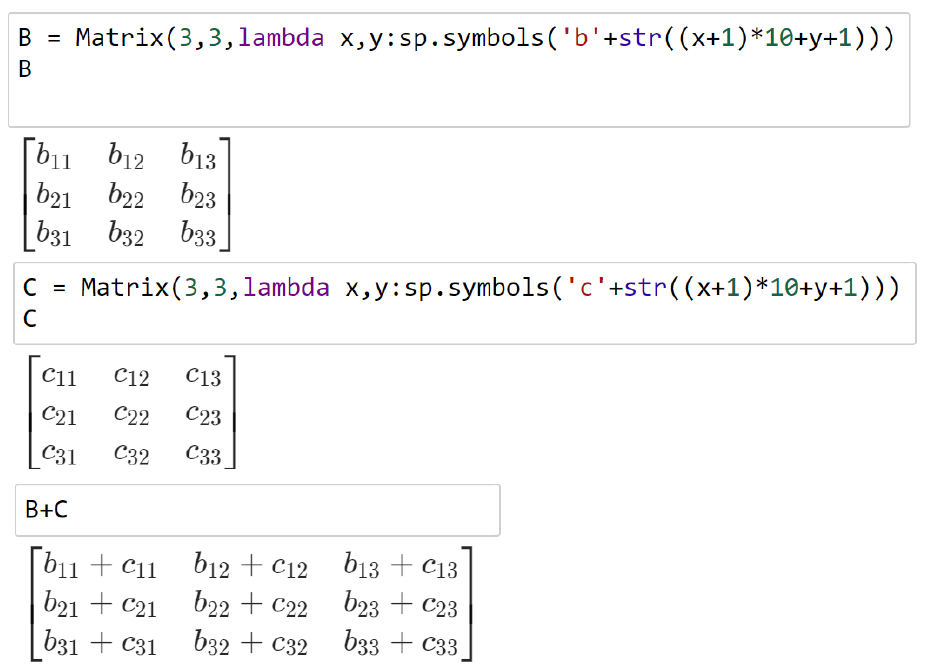
Figure 10. Matrices with symbolic contents.